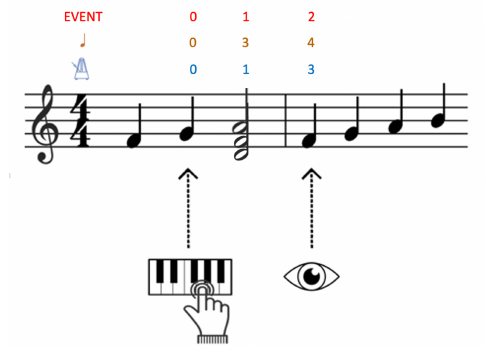
Figure 3. Representation of EHS measured in musical units. In red the EHS measured in number of events, in orange the EHS measured in number of notes, and in blue the EHS measured in number of beats.